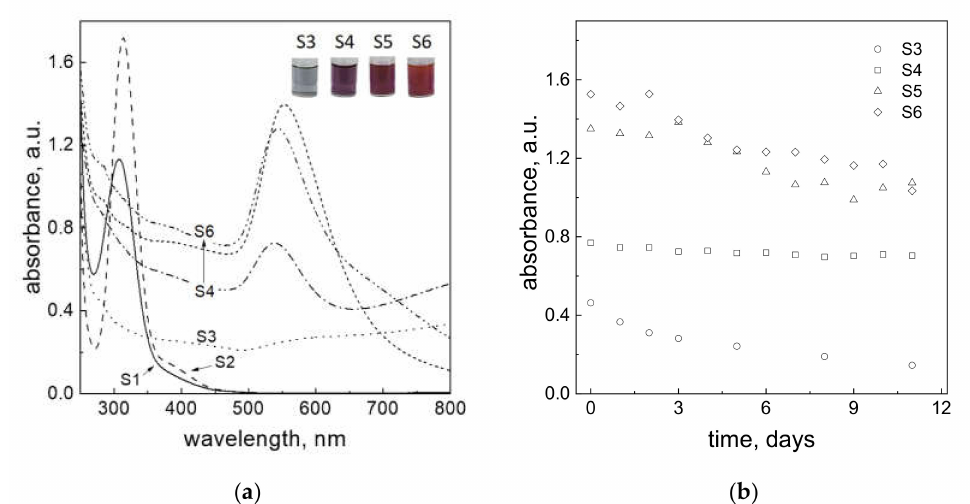
Figure 3. Spectra of solutions S1–S6 and the colour of colloidal gold obtained in the batch reactor (S3–S6) ( a ); Kinetic curves for process of colloidal gold adsorption on carbon fibers carried out in the batch reactor ( b ). Conditions: C 0, Au(III) = 0.3 mM, C 0, H2Asc = 0.6 mM, addition of PVA (samples S4, S6), amount of the carbon fibers 0.025 g/25 mL of the solution, T = 20 ◦